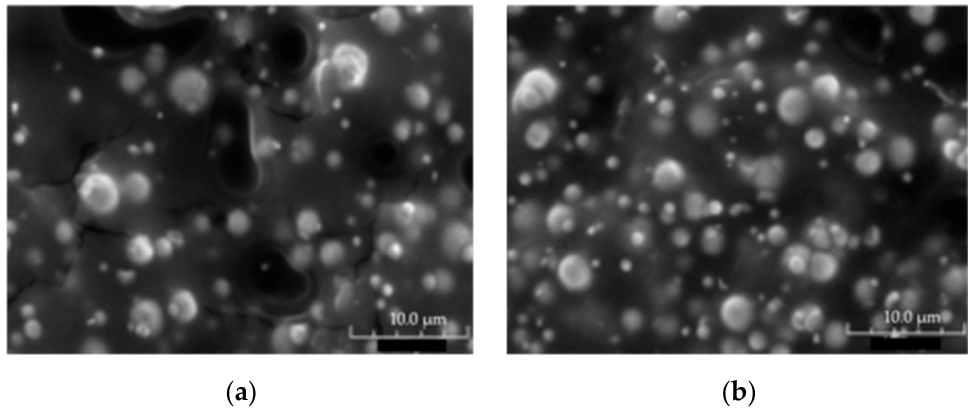
Figure 8. Scanning electron microscopy images of ( a ) the magnetic filament, ( b ) printed sample with